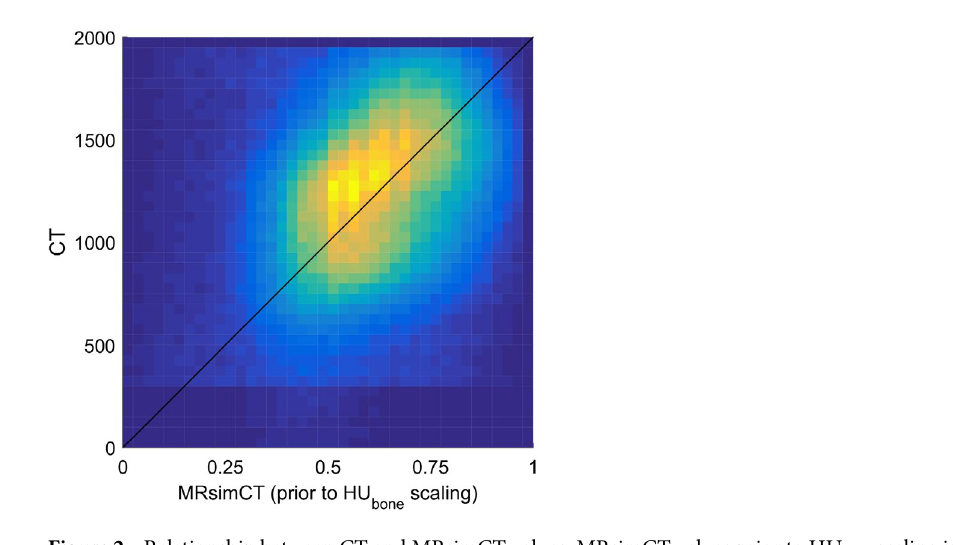
Figure 2. Relationship between CT and MRsimCT values. MRsimCT values prior to HU bone scaling in (2) span a range from 0 to 1 and can be used as an estimate for bone fraction. For the CT parameters used in this study, pure bone was calculated to have a value of 2000 HU 36 . The black line depicts the nominal relationship between CT and MRsimCT values. Because only three ex vivo skulls were used in this study, using a linear regression to predict CT HU from MRsimCT values may overfit to the data. Therefore, the nominal linear relationship was used to predict CT HU